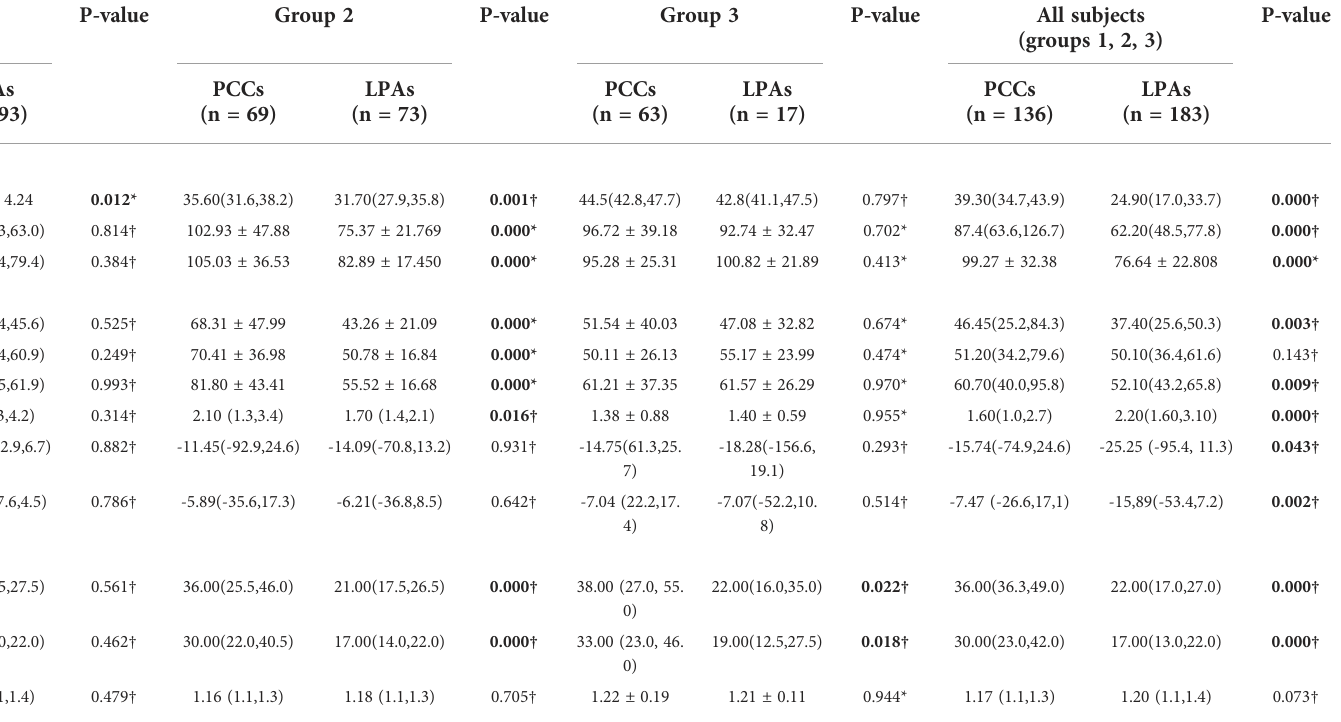
TABLE 2 Quantitative CT features between adrenal PCCs and LPAs on the training